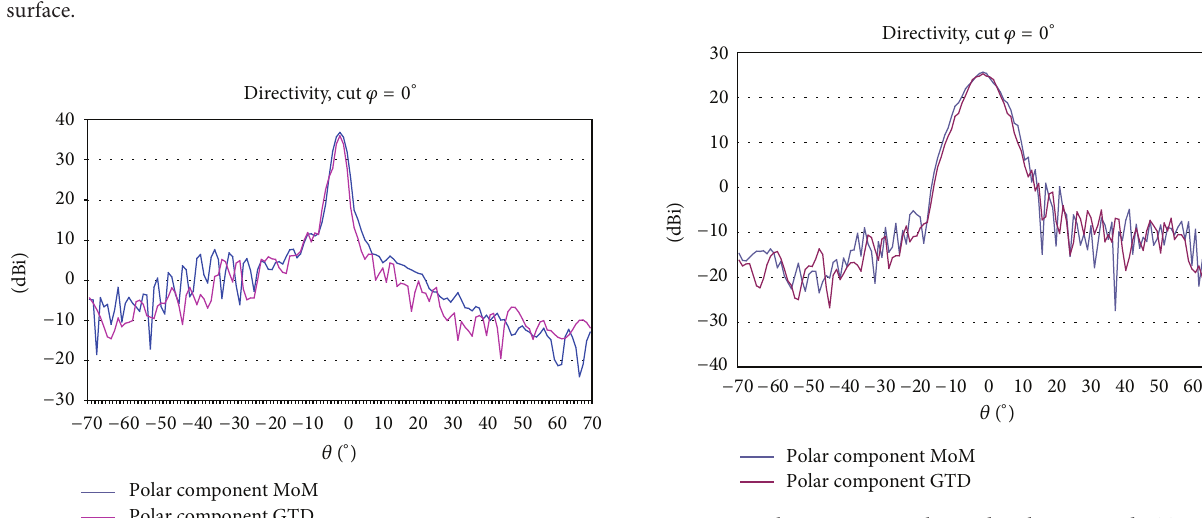
Figure 31: Polar component obtained with MoM and GTD, cut in 𝜑 = 0 ∘ .